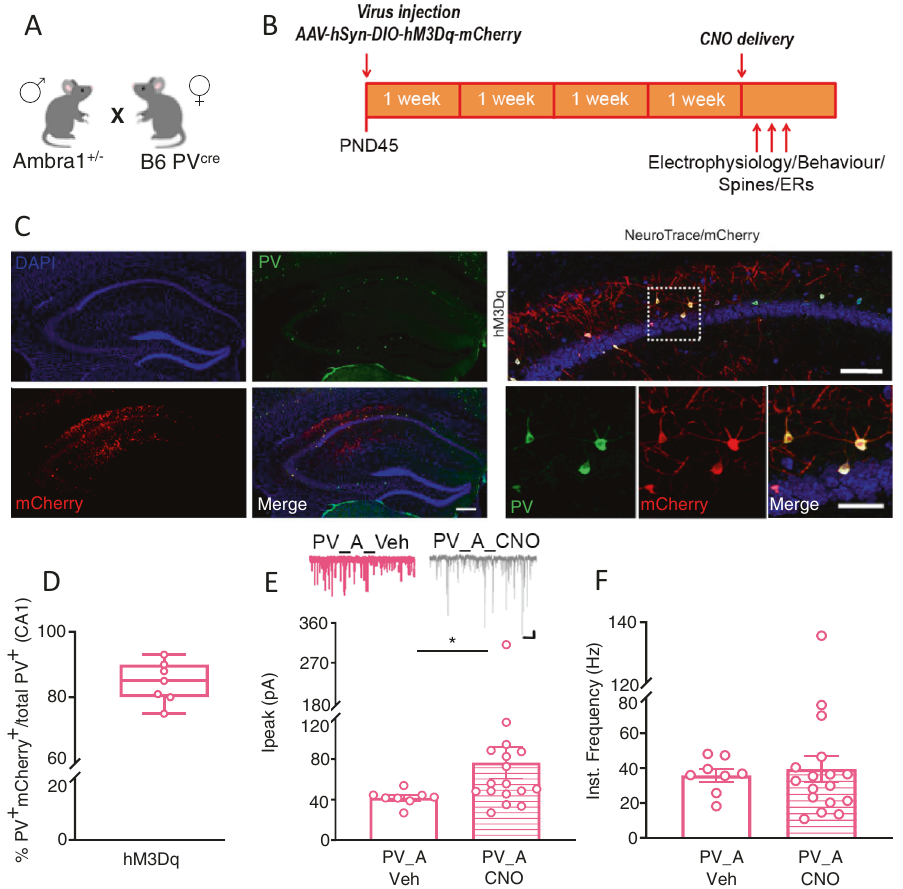
Fig. 1 Chemogenetic activation of PV-IN enhances the GABAergic tone onto CA1 pyramidal neurons. A Breeding. B Experimental design: AAV-hSyn-DIO-hM3Dq-mCherry (hM3Dq) was bilaterally injected in CA1. Tests were performed 4 weeks later. Vehicle (Veh) or CNO were injected i.p. 40 min before behavioral testing and electrophysiological recordings, and 70 min before rtPCR experiments, or diluted at the same concentration in the drinking water 24 h before mice were sacri fi ced for dendritic spine analysis. C Left panels: low magni fi cation image depicting the selective stereotaxic infusion of AAV-hSyn-DIO-hM3Dq-mCherry in the CA1. Scale bar: 200 μ m. Right panels: representative images of CA1 NeuroTrace/PV/mCherry labelling showing overlapping signals (yellow) of mCherry (red) and PV + interneurons (green). Scale bars: top, 250 μ m; below, 50 μ m. D Percentage estimation of PV-IN infected with the hM3Dq AAV (PV + mCherry + /total PV + ). In box-and-whisker plots the centre lines denote median values, edges are upper and lower quartiles, whiskers show minimum and maximum values and points are individual experiments ( N = 7 for hM3Dq). E – F sIPSCs in CA1 neurons from hM3Dq PV_Ambra1 + / − females injected with Veh (left) or CNO (right). Scale bar: 1 s, 20 pA. CNO increased the inhibitory tone onto CA1 neurons. E Peak amplitude ( p = 0.013, Mann-Whitney test). F Instantaneous frequency. N = 8, 17 neurons, from 3 Veh- and 5 from CNO females. Data are expressed as mean ± s.e.m. * p < images (Motic Live Imaging software) using ImageJ (NIH, USA) software. NOR test . The apparatus consisted of a squared Plexiglas cage (40 cm L × Spine head diameter values were expressed as cumulative frequencies. To 40 cm W × 34 cm H). The test included three phases (phase 1: exploration avoid technical bias on spine head measurements, all groups were of the empty apparatus; phase 2: training; phase 3: testing) of 5 min each represented in a balanced manner in each staining experiment. To separated by 1 min intervals. During training, mice were exposed to two strengthen the validity of our observations, a subset of randomly selected objects identical in size, black/white colour pattern, and shape. During dendritic spines for each group was analyzed using a recently reported testing, mice were exposed to one previously explored (familiar) object left new method [25] that allows ef fi cient and unbiased classi fi cation of in its original location and a novel object of a comparable size but differing dendritic spines based on an objective basis that consider the unique in black/white colour pattern and shape that was put at the location of the geometry of different spine shapes. In more detail, we measured spine removed familiar object. Habituation of the open fi eld exploration was head width and length with the freely available RECONSTRUCT software estimated by measuring the velocity (cm/s) and the distance travelled (http://synapses.clm.utexas.edu.) [26]. After spine length and spine head using Noldus EthoVision XT software. Exploration of objects was measured width data sheet was constructed as in [26], we calculated the length-to- by recording manually the time spent in contact with each identical object width ratio (LWR) to infer the spine category each spine was belonging to. (training) and with the familiar and the novel object (testing) using The formula is hierarchical and classi fi es spines as follows: mushroom chronometers. In phase 3 (testing), a recognition index (RI = time in spine, when the width value >0.6 µm; long thin spine, when the length contact with the unfamiliar object /time in contact with the unfamiliar + value >1 µm; thin spine, when the LWR value >1; stubby spine, when the familiar object) was calculated. LWR value ≤ 1. Dendritic spine analyses Golgi staining was performed as in [13]. Dendritic spines were counted on randomly selected 30 – 50 μ m dendritic segments of CA1 dendrites using the computer-based neuron tracing system (Neurolucida; MBF Bioscience, Williston, VT). Spine head diameters were measured on previously acquired